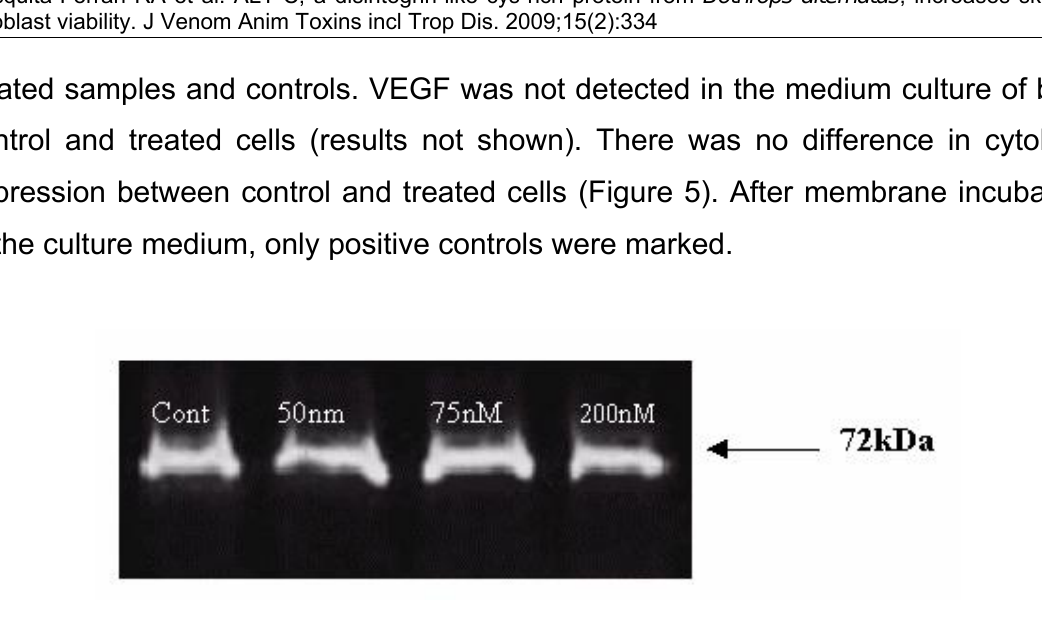
Figure 4. Protease expression detected by zymography, using a culture medium from myoblasts treated with ALT-C and from control (without ALT-C), at different concentrations, 48 hours after incubation. The arrow indicates a band of ~72 kDa with protease activity.